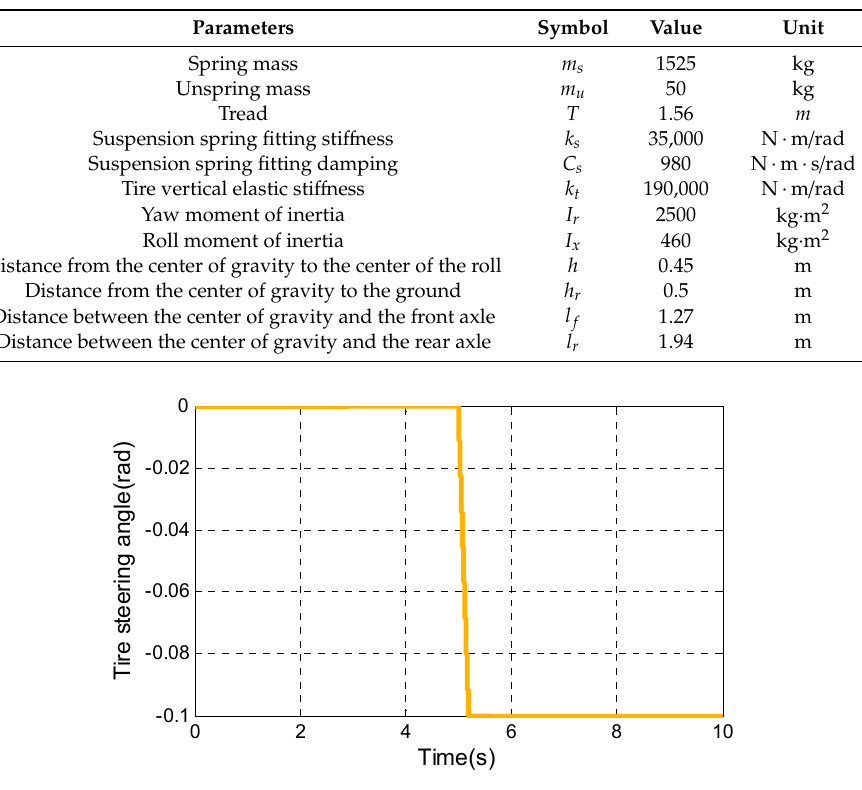
Table 1. The parameters of the rescue vehicle’s suspension system.